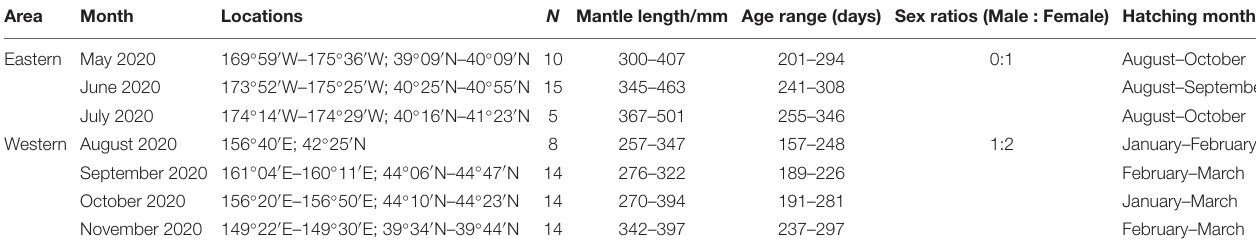
FIGURE 2 | Image of statolith. Line indicates the direction of age estimation and ablation (from the central nucleus to the rostrum edge). Circles indicate regions where material has been ablated. TABLE 1 | Data of statolith samples tested by the microchemical analysis of Ommastrephes bartrammi . Area Locations